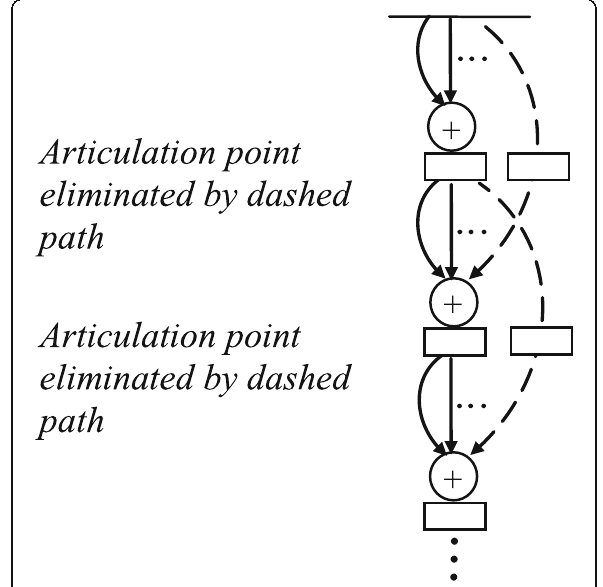
non-zero digits with the minimum number of n -input R -operations, p , and the minimum number of depth levels, p